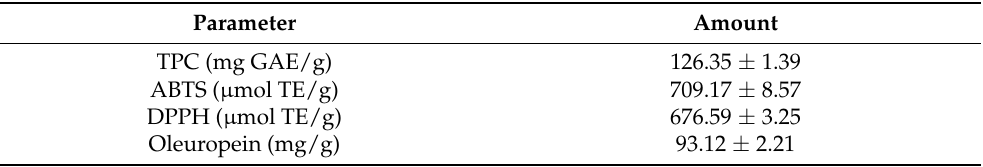
Table 2. Total polyphenolic content (TPC), antioxidant activity (ABTS, DPPH) and oleuropein content of the olive leaf extract ( n =